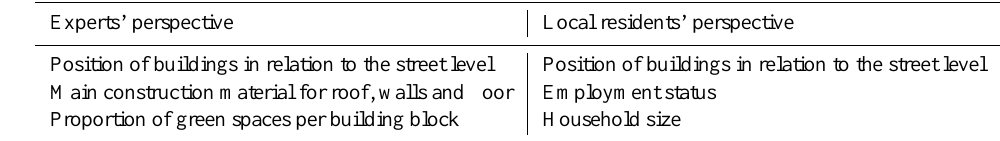
Fig. 2. Location of the surveyed households with their predominant type of flood-related damage and location of the flood hazard β -zones after according to the Regional Development Plan. Table 3. Most explanatory variables: experts’ and residents’